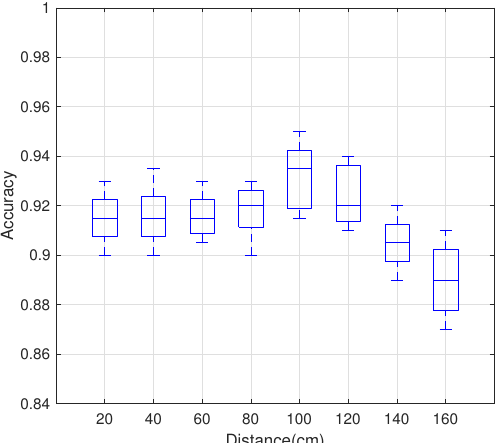
Figure 10. Impact of distance between hand and device on the recognition